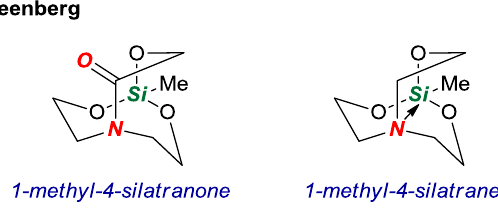
Figure 8. Computational Study of 1-Methyl-4-Silatranone.